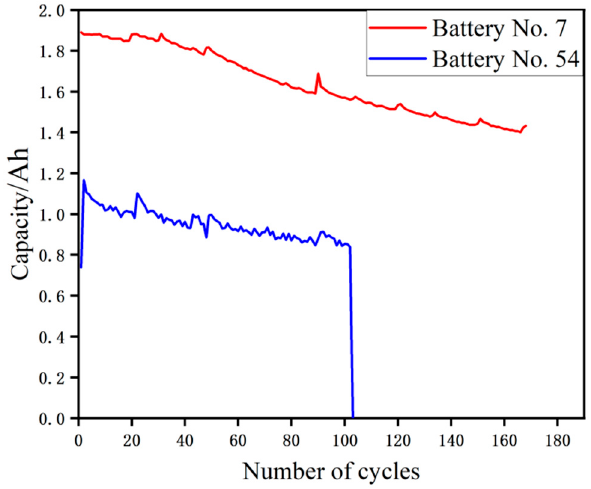
Figure 2. NASA-Battery Data Set No.7 and No.54 battery capacity change.